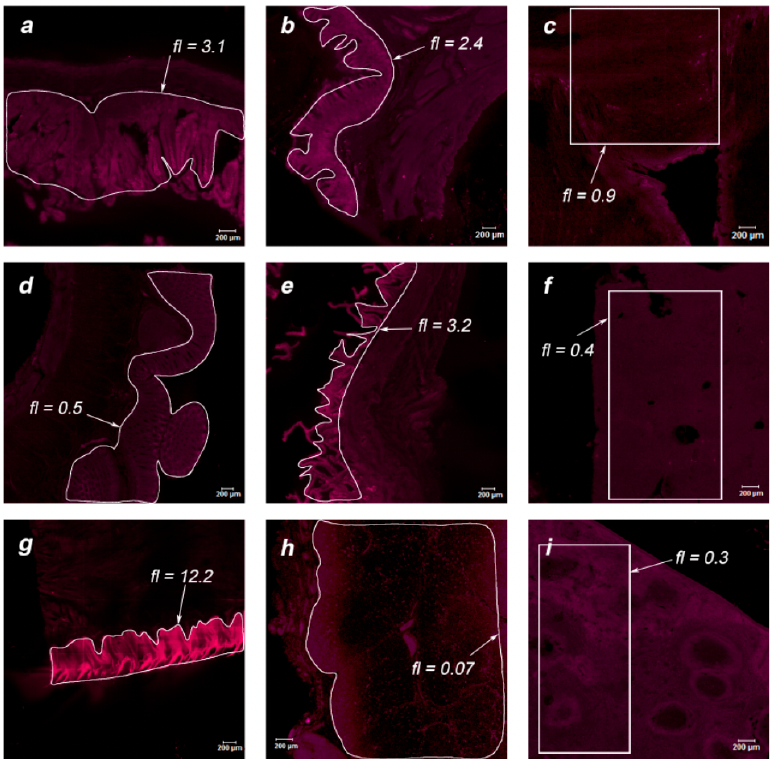
Figure 8. Images of organs of Primate A (3 h after MB administration) obtained using laser scanning confocal microscopy: ( a ) jejunum; ( b ) stomach; ( c ) intestinum crassum; ( d ) colon; ( e ) gallbladder; ( f ) liver; ( g ) tongue; ( h ) thymus; ( i ) spleen. Areas of interest are highlighted in white, according to the accumulated MB. The index corresponds to the level of MB in this area of